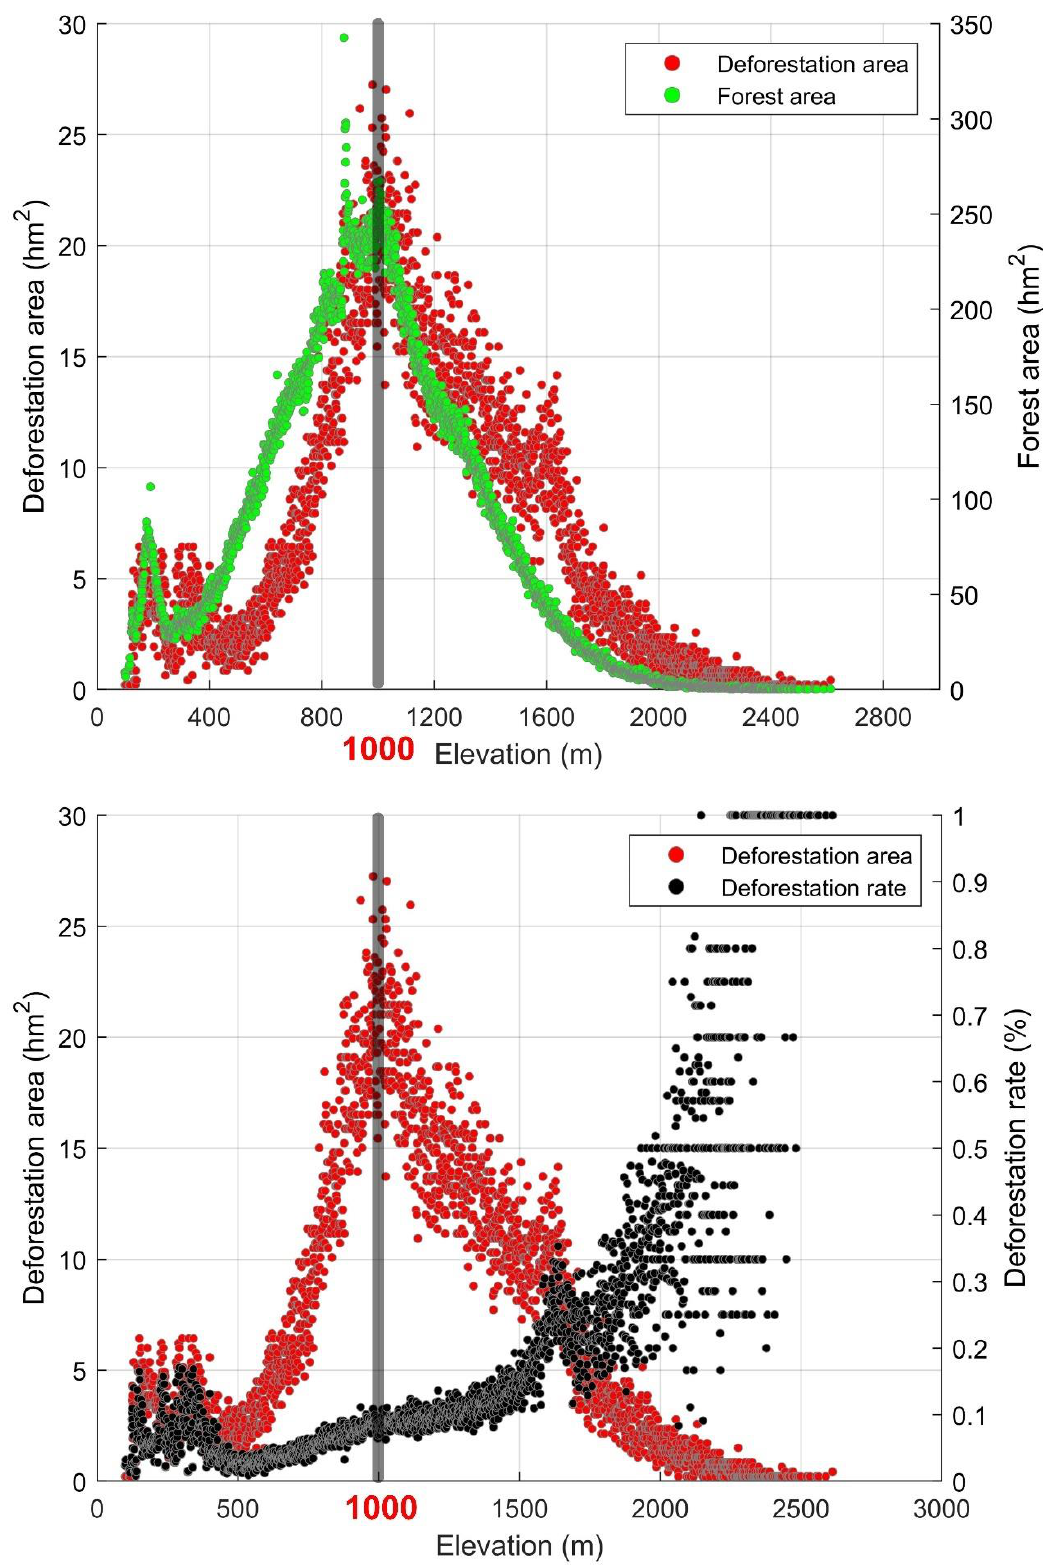
Figure 5. Deforestation area, forest area, and deforestation rate by elevation from 2003 to 2015 in upland Myanmar.